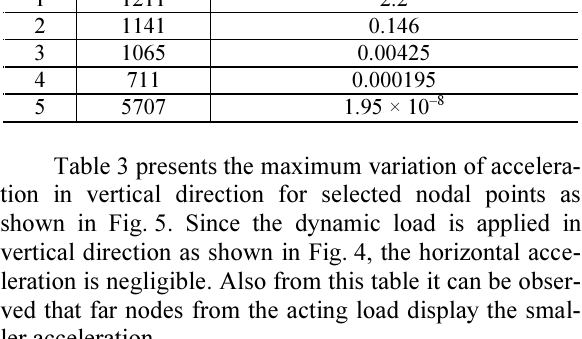
Table 2. Variation of maximum vertical displacement for se- lected nodes No. Node No.